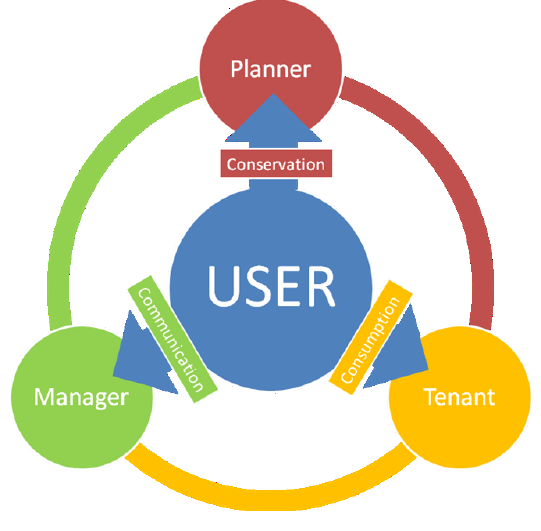
Figure 3. User-Demand